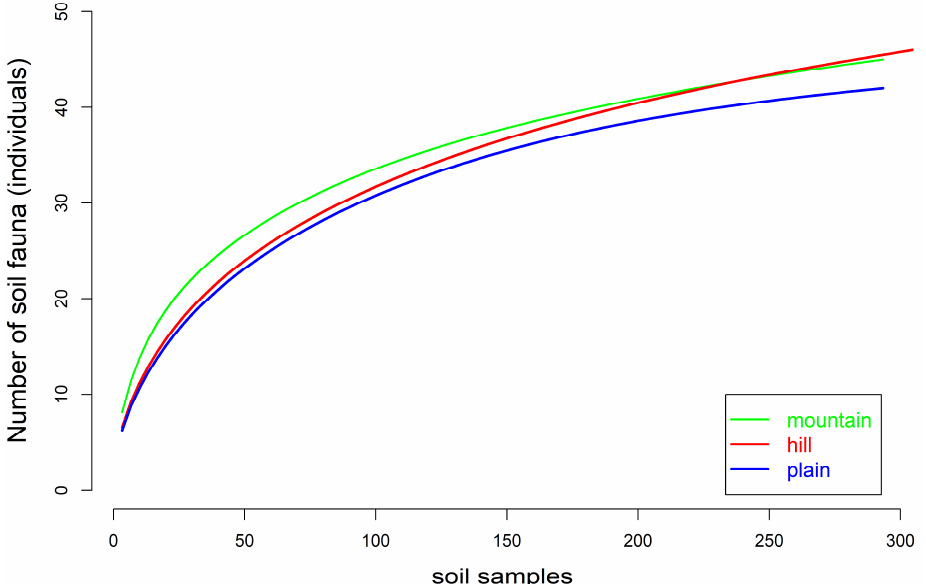
Figure A1. Species cumulative curves of the study area. The green line represents the species cumulative curve of mountainous landform, the red line represents the species cumulative curve of hilly landform, and the blue line represents the species cumulative curve of plain landform.